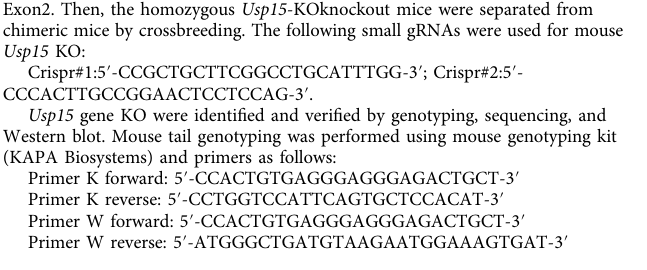
Fig. 6 USP15 maintains genome stability in vivo. a Usp15 protein is absent in Usp15 − / − mouse embryonic fi broblasts (MEFs). Cell lysates from Usp15 + / + and Usp15 − / − MEFs were separated by sodium dodecyl sulfate (SDS) gel and blotted with indicated antibodies. b Representative γ -H2AX foci of untreated primary Usp15 + / + or Usp15 − / − MEF cells (passage 2) are shown (left panel). Scale bar: 20 μ m. Quanti fi cation are mean±SD of three independent experiments, and 100 cells per experiment were counted. Two-tailed Student's t test, * P < 0.05. c Five-week-old Usp15 + / + ( n = 16), Usp15 + / − ( n = 19), and Usp15 − / − ( n = 25) littermates were subject to 8.5Gy X-ray radiation, mice were monitored daily, and survival was assessed by Kaplan – Meier curve and log-rank test. d Fourteen days after mice were treated as in c , they were dissected and tissues were subject to immunochemistry (IHC) with γ -H2AX antibody. Representative γ -H2AX IHC staining of indicated tissues are shown. e MTS assay of Usp15 − / − MEFs compared with Usp15 + / + MEFs in response to increasing doses of camptothecin (CPT), mitomycin C (MMC), and poly-(ADP-ribose) polymerase (PARP) inhibitor (AZD2281) were performed. Data are presented as mean ± SEM of three independent experiments. f Metaphase spreads to analyze chromosome aberrations in untreated primary Usp15 + / + or Usp15 − / − MEFs (Passage 3) were performed (left panel). Quanti fi cation of indicated aberrations are mean of three independent experiments, and